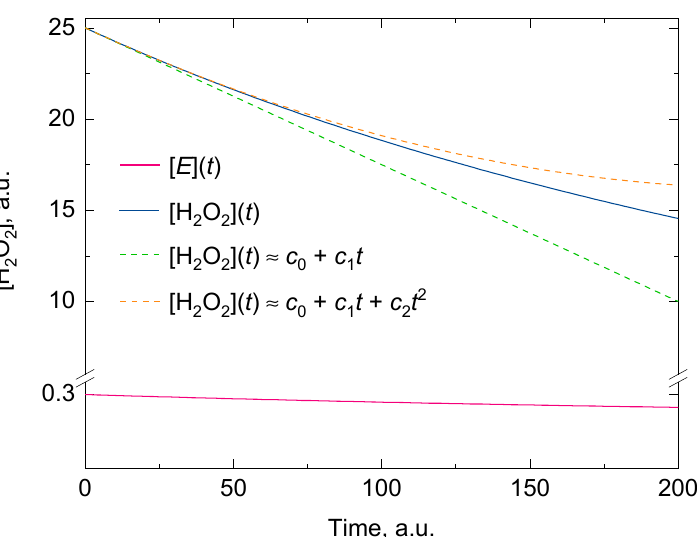
Figure 1. A representative analytical solution of the kinetic model for the two concurrent second-order reactions leading to H 2 O 2 decomposition by catalase (solid blue line) and its inactivation by H 2 O 2 (solid red line). The dashed green and dashed orange lines are the polynomials of degree one and two obtained at t = 0 from the Taylor series of the exponential analytical solution of [H 2 O 2 ]. The polynomial of degree two shows a better overlap with the analytical solution for t > 0. The initial conditions for [H 2 O 2 ] and [ E ] were 25 and 0.3 arbitrary units and the values for the overall forward rate constants (i.e., k 1 and k 2 ) of the second-order reactions were 0.01 and 0.00005 arbitrary units, respectively. As t approaches infinity, [H 2 O 2 ] approaches the value of [H 2 O 2 ] o (1 − k 1 [ E ] o / k 2 [H 2 O 2 ] o ). Here the condition k 2 [H 2 O 2 ] o > k 1 [ E ] o holds. More details are given in the main body of text.